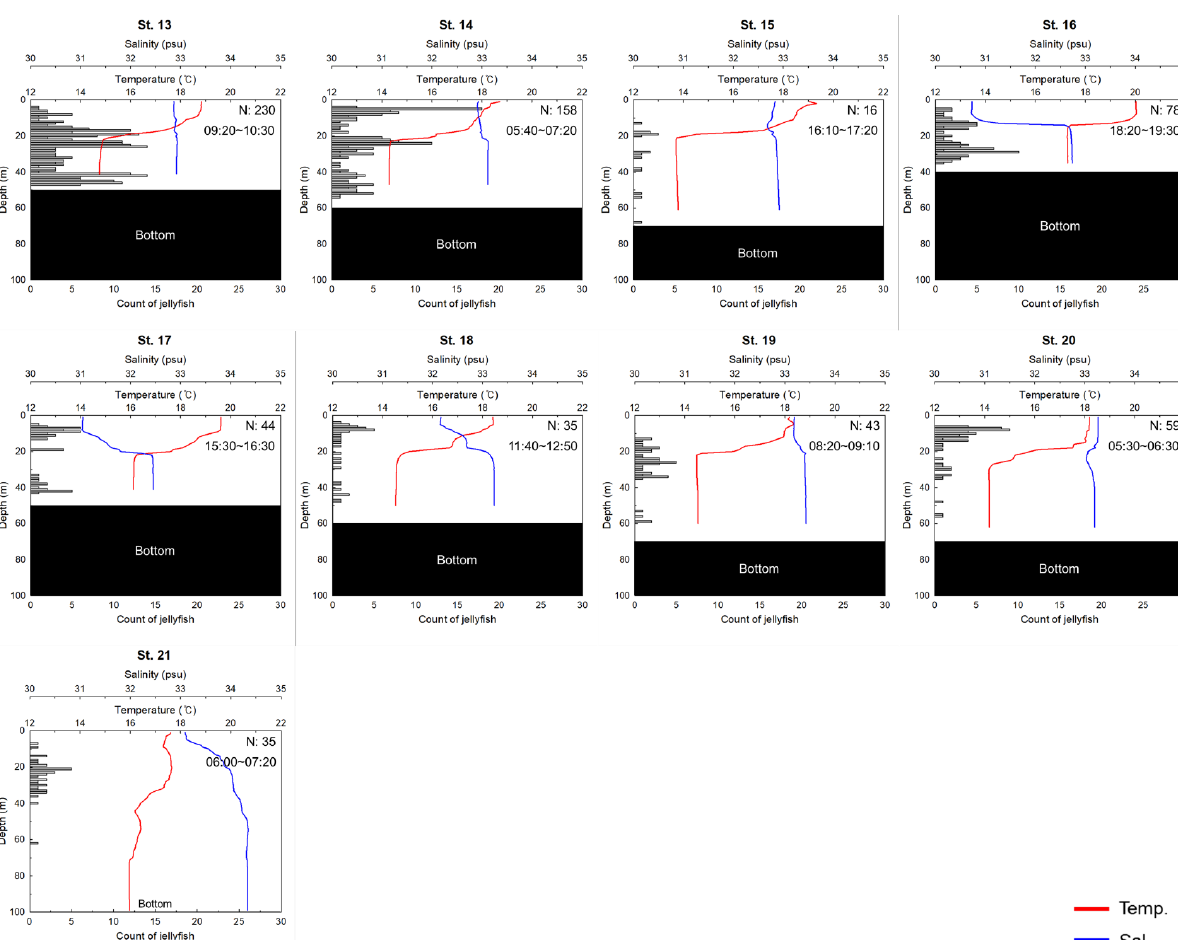
Figure 6. Distribution of the water layer in the East China Sea. Table 2. Distribution density of jellyfish using the echo counting method in the East China Sea. Site Ind.